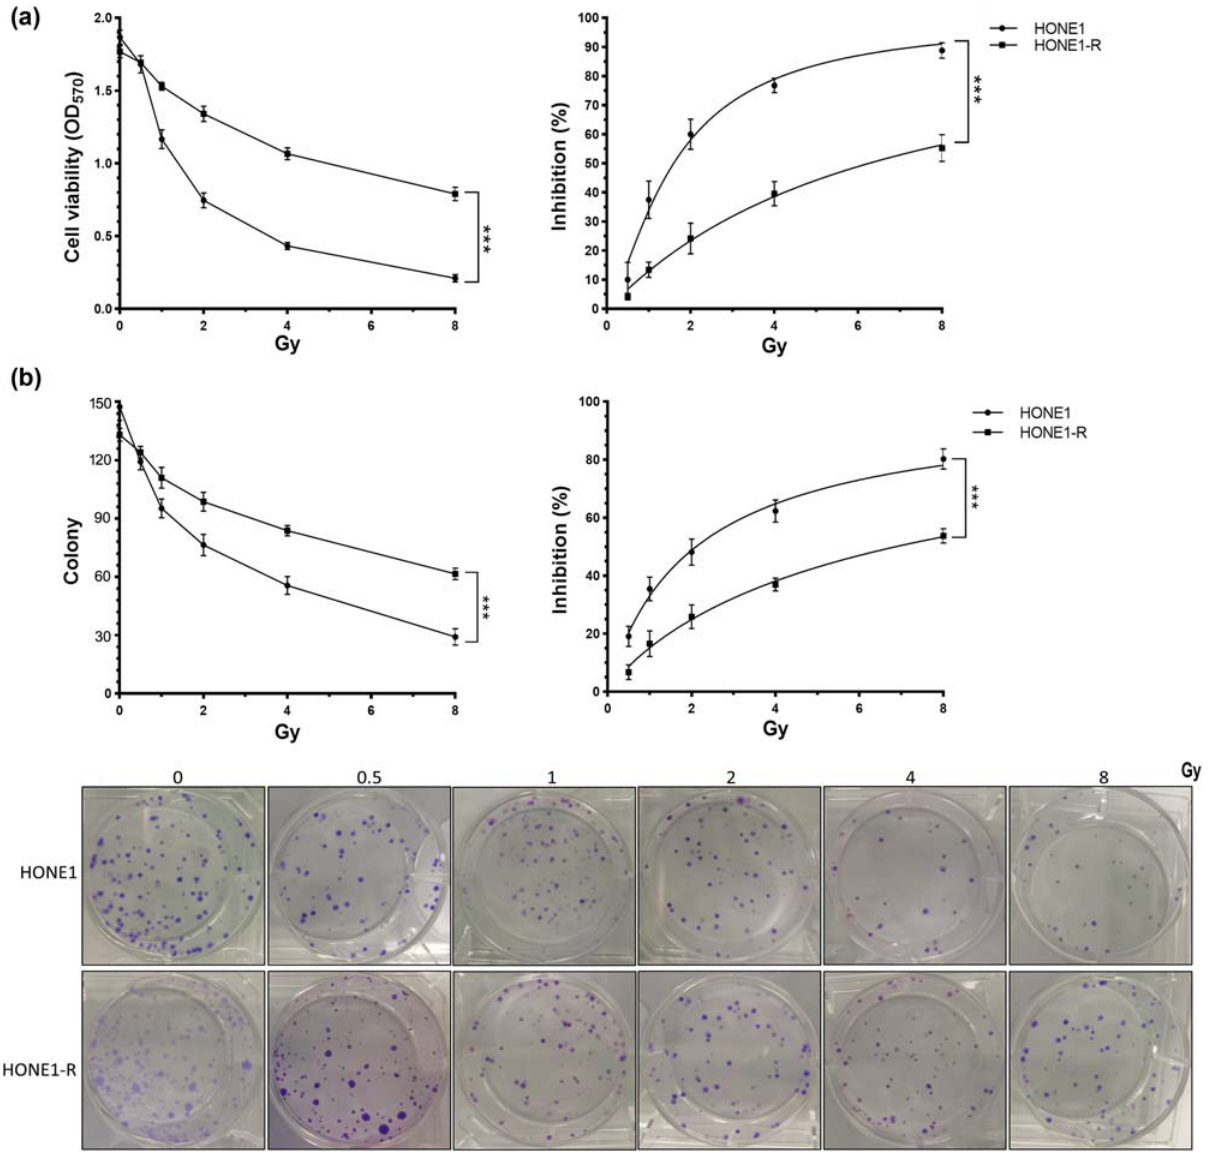
Figure 2: Determination of IC 50 on cell viability and proliferation of HONE1 and HONE1 - R cells: ( a ) IC 50 of radiation suppression on cell viability and ( b ) IC 50 of radiation suppression on cell